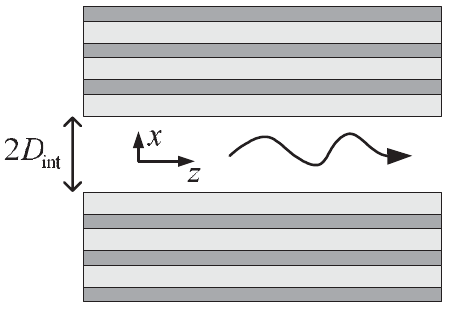
FIG. 1. Planar optical Bragg acceleration structure.*Electronic address: